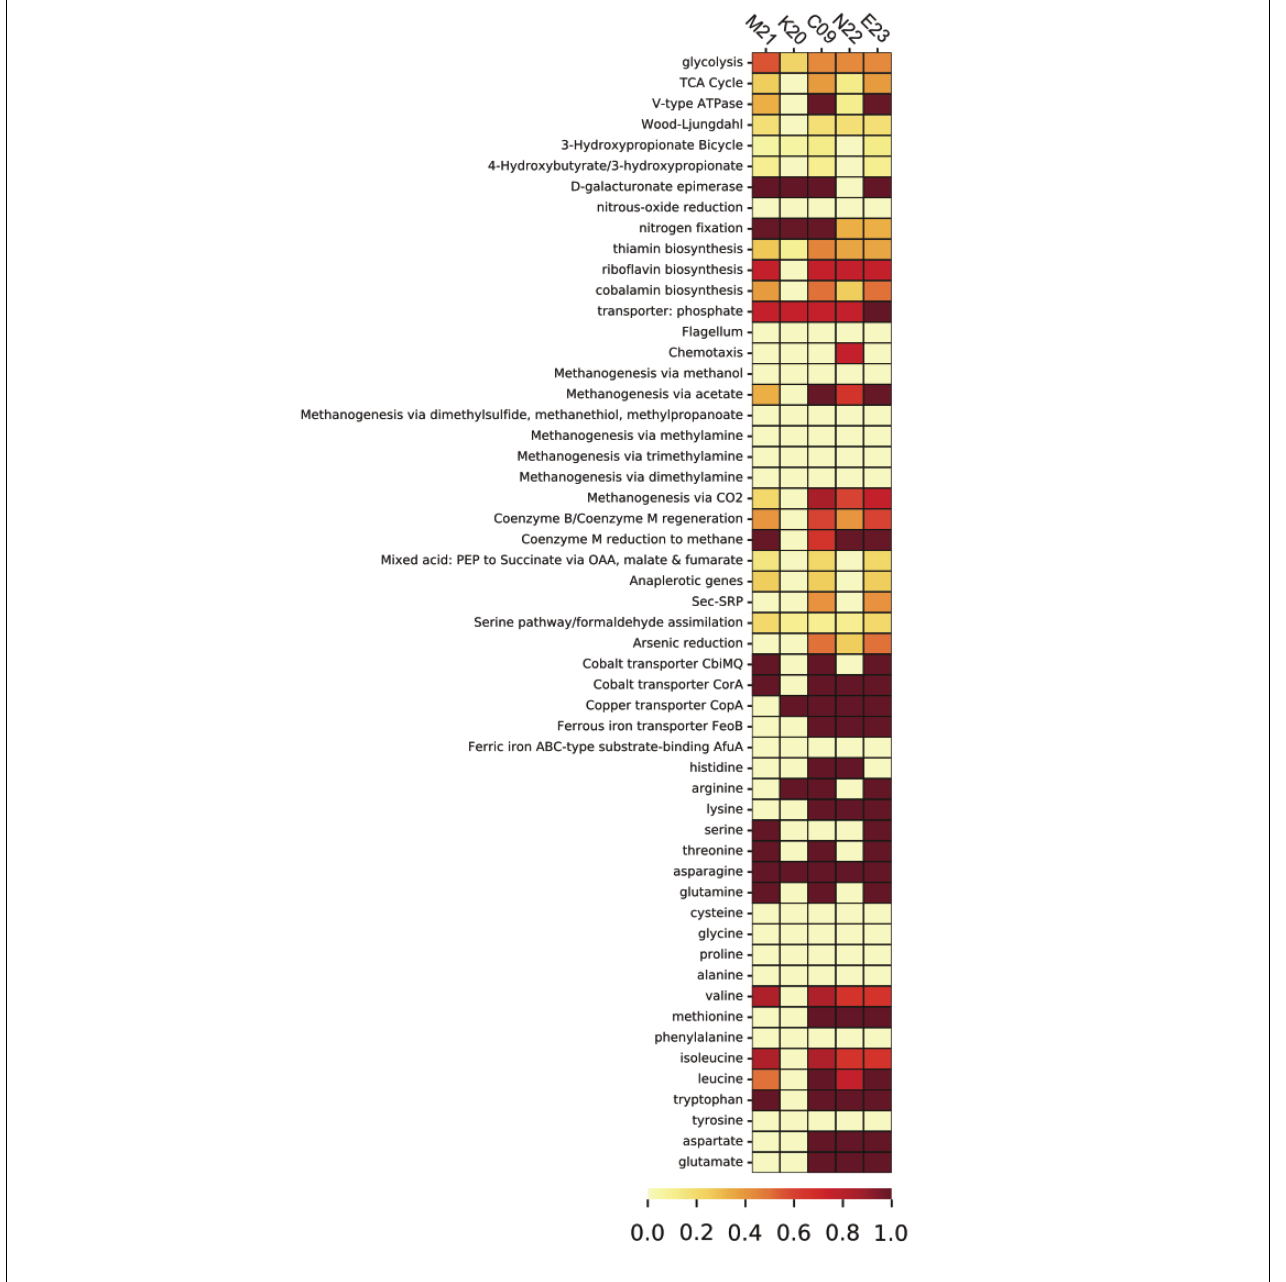
FIGURE 3 | Heatmap depicting pathway completeness of selected metabolic pathways in each of the five Methanothermococcus SAGs. Darker values indicate more complete